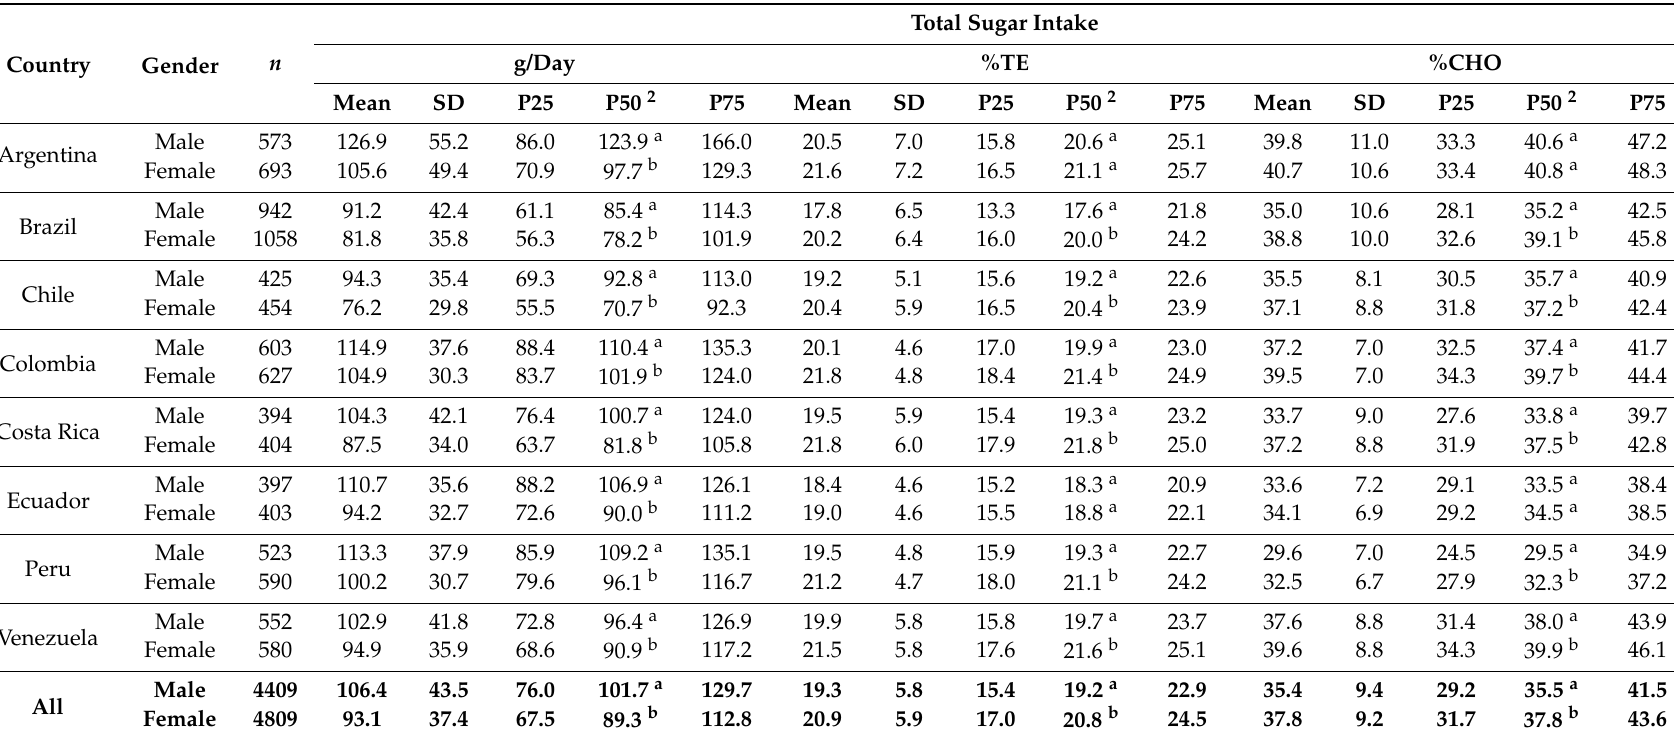
Table 3. Total sugar intakes 1 in individuals residing in urban areas of Latin American countries, according to gender; Latin American Health and Nutrition Study (ELANS),